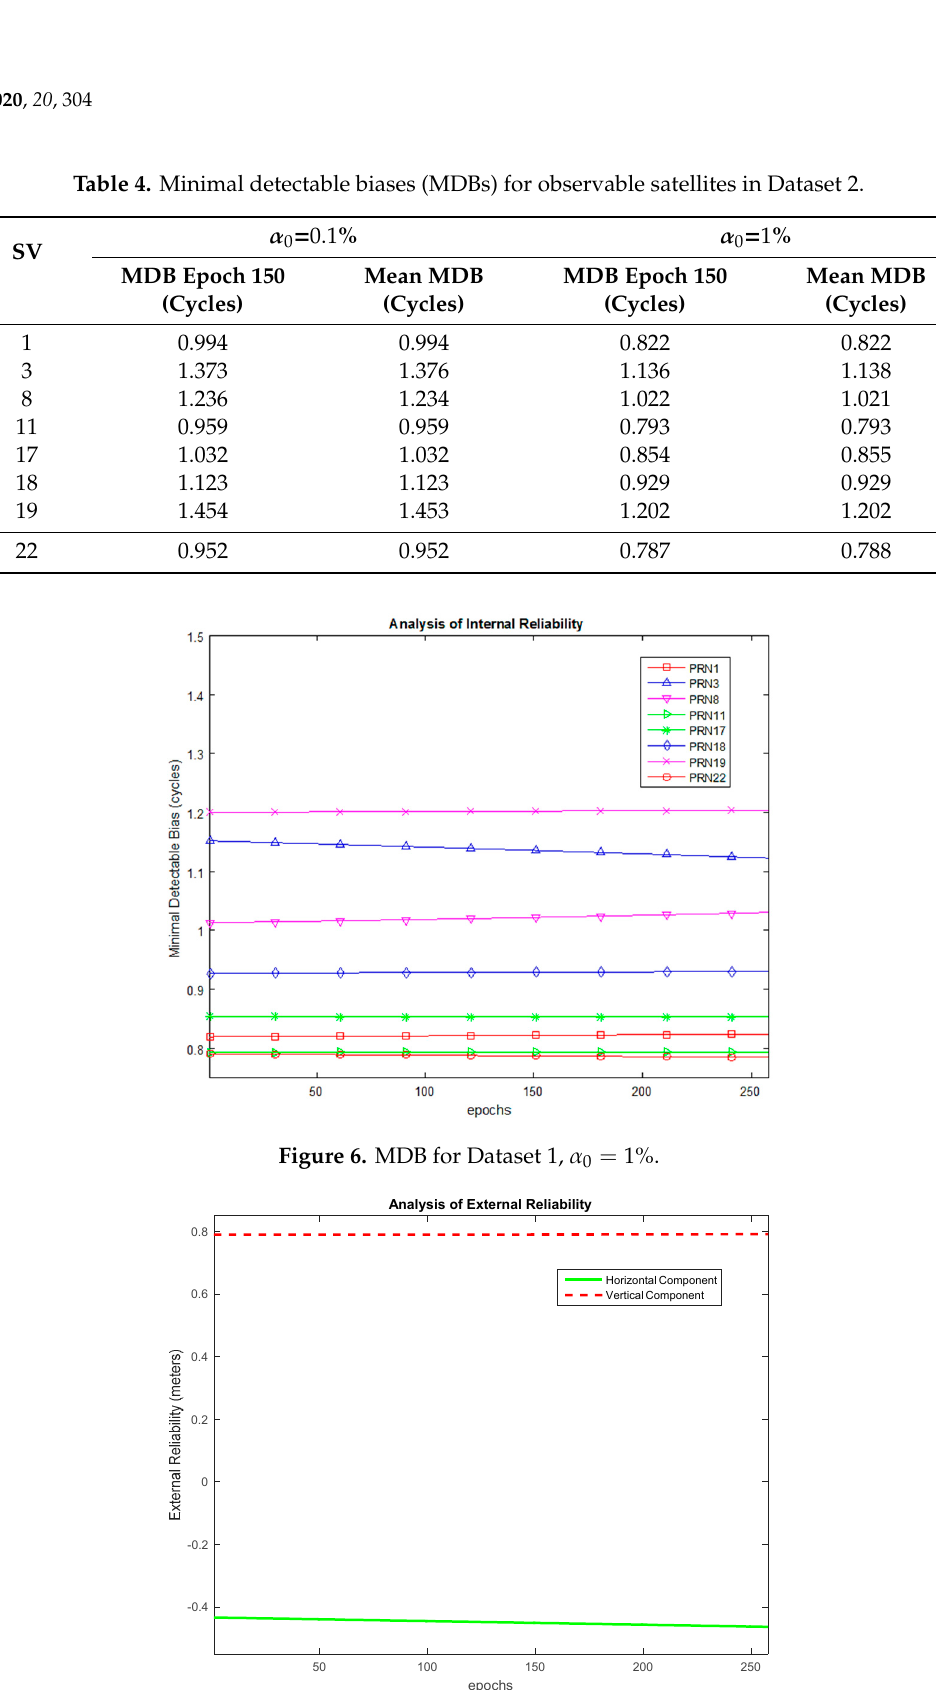
Figure 7. External reliability assessment for Dataset 1, α 0 =